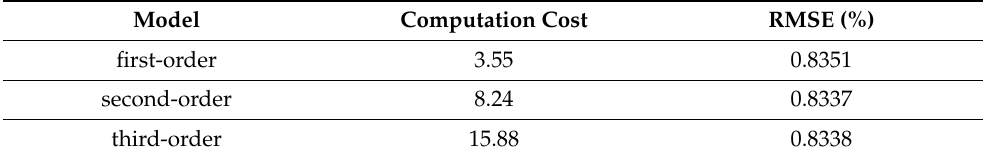
Table 3. Model Comparison.